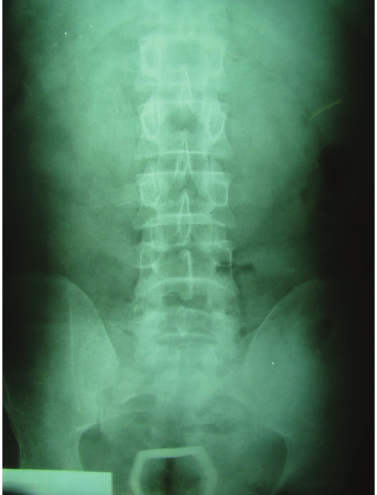
Figure 3: X-rays visualized a glass leading